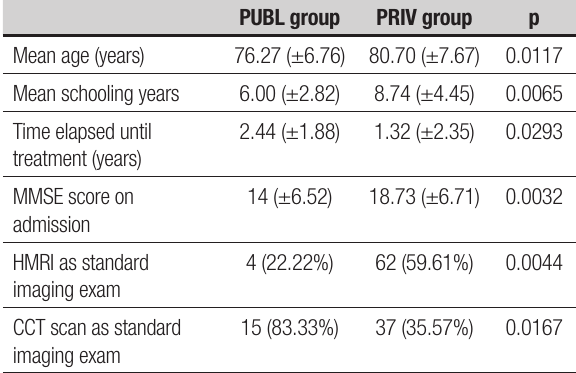
Table 4. Clinical features of patients with Alzheimer’s disease.